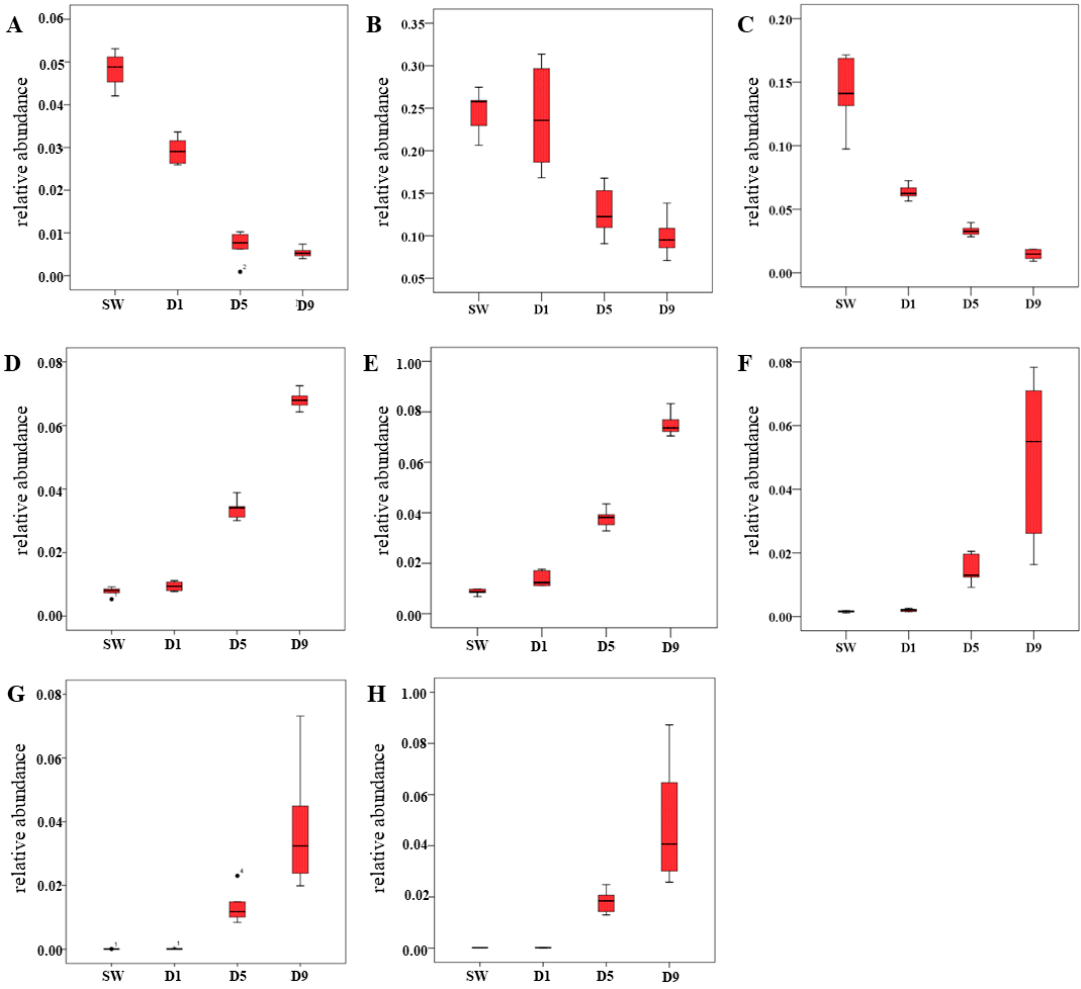
Figure 5. Relative abundance of eight chemical constituents. ( A ) L-Histidine; ( B ) choline; ( C ) 2-pyrrolidone-5-carboxylic acid; ( D ) L-carnitine; ( E ) betaine; ( F ) 6-hydroxynicotinic acid; ( G ) quercetin-7- O - β - D -4- O -methylglucoside; ( H ) kaempferol-7- O - β - D -4- O -methylglucoside.